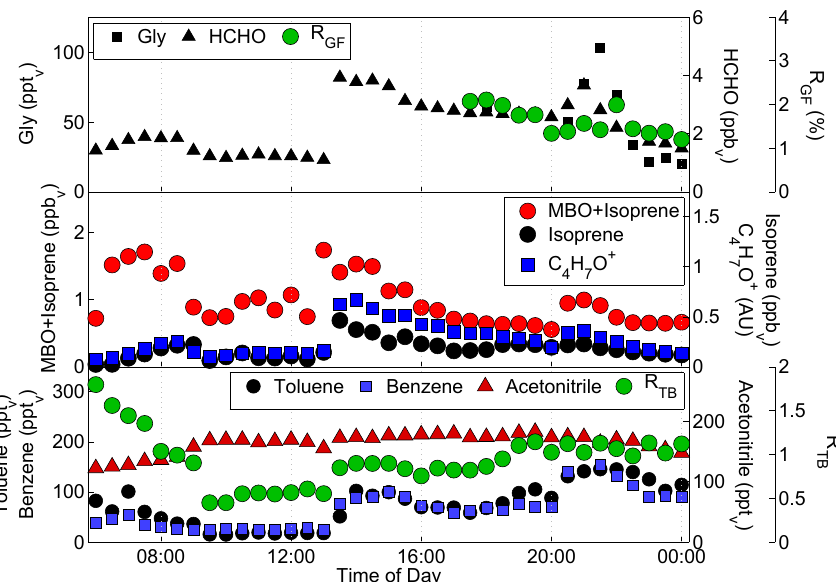
Fig. 5. Gly, HCHO, R GF and other tracer species during day BN3 (DOY 226). Gly, HCHO, and R GF are shown as 30 min binned averages ( ± 15 min each half hour), whereas other species are shown at full resolution. Data for MBO+Isoprene, C 4 H 7 O + , benzene, and acetonitrile were measured via PTR-TOF-MS. Data shown for toluene was measured via TOGA, and R TB is based on TOGA measurements of benzene and